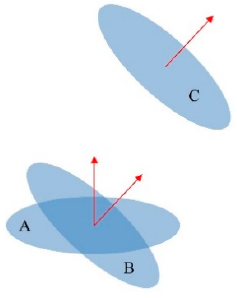
Figure 10. Shape transformation.